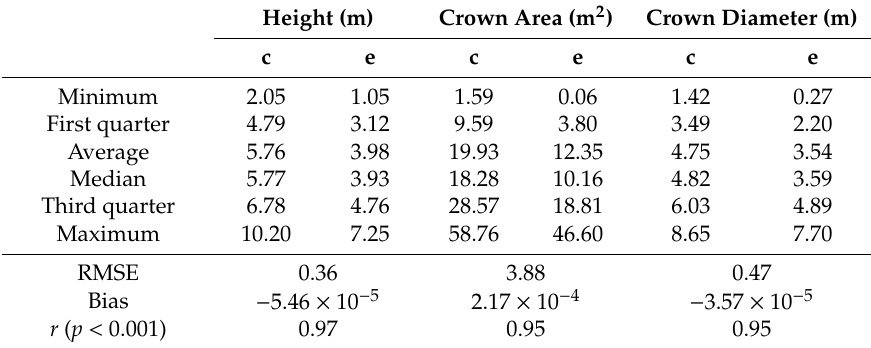
Table 3. Statistical evaluations of tree-level characteristics recorded and estimated from 112 trees detected in the clonal orchard.